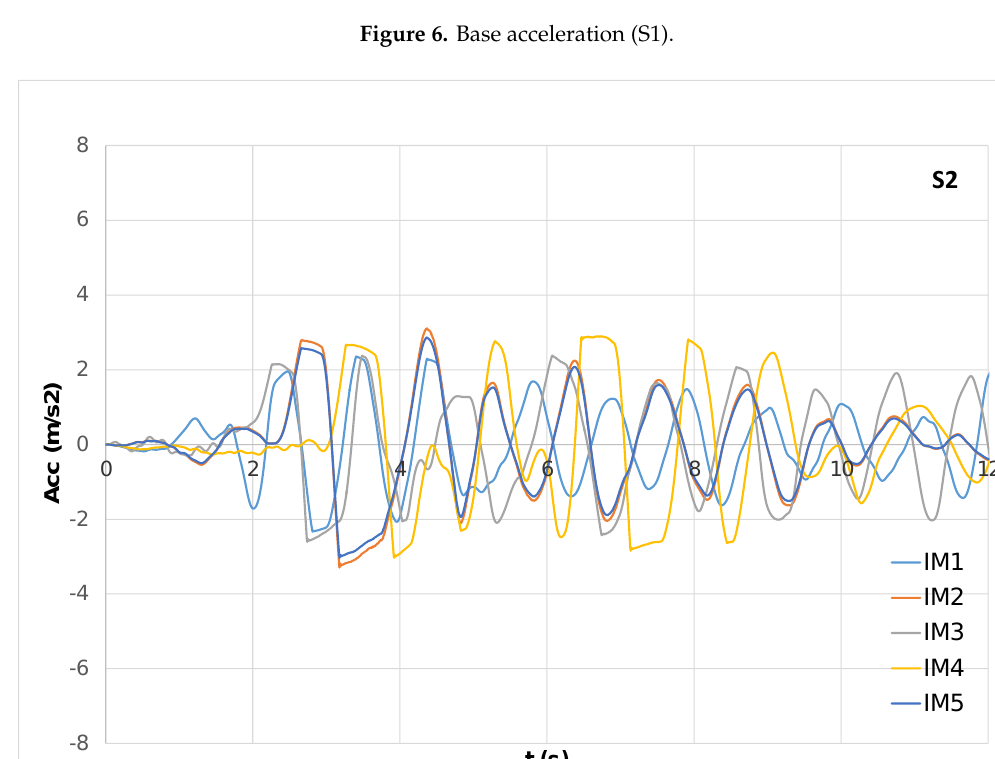
Figure 7. Base acceleration (S2).